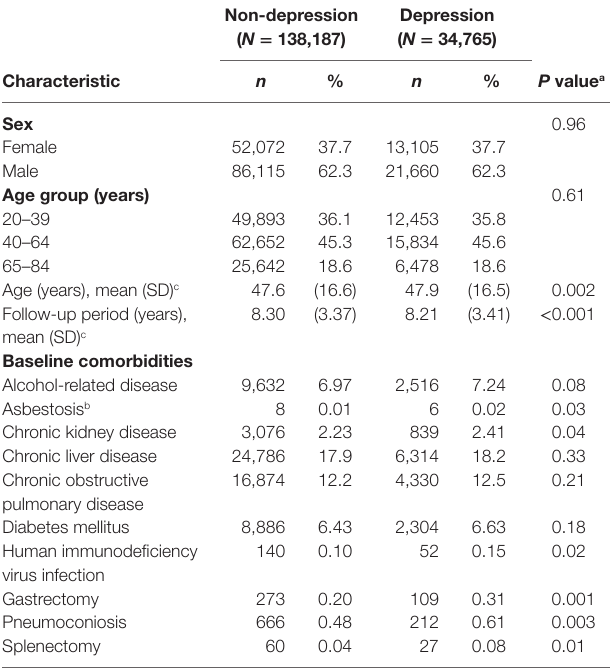
TaBle 1 | Baseline characteristics between depression group and non- depression group.